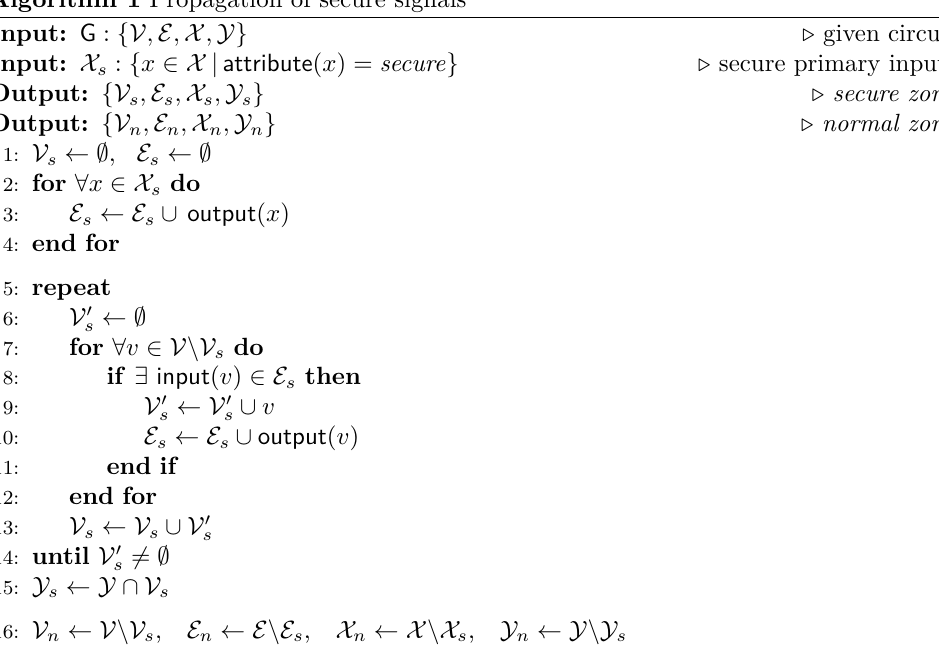
Algorithm 1 Propagation of secure